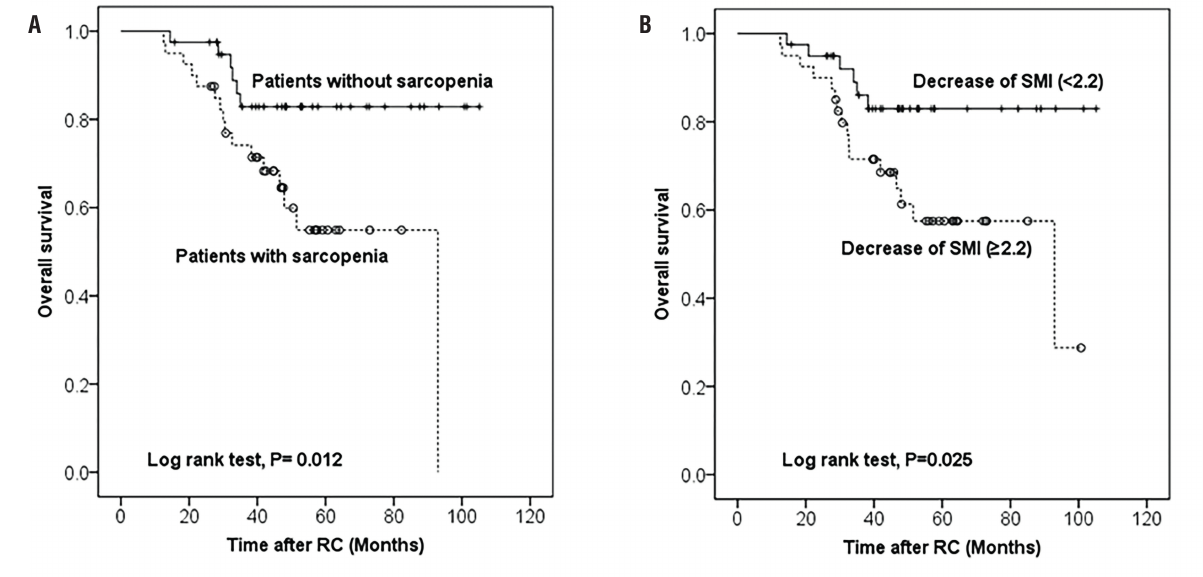
Figure 2 - Kaplan-Meier curve depicting overall survival according to postoperative sarcopenia (A) and change in skeletal muscle index (SMI)